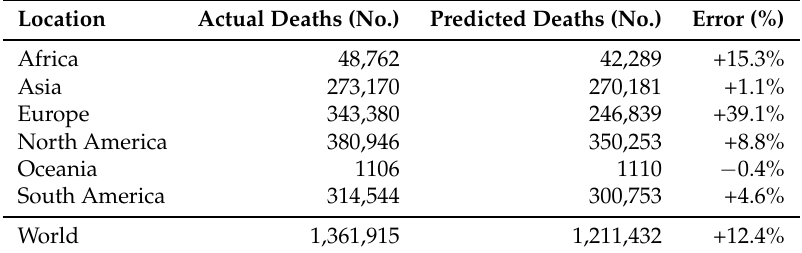
Table A1. Actual and predicted number of deaths as of 20 November